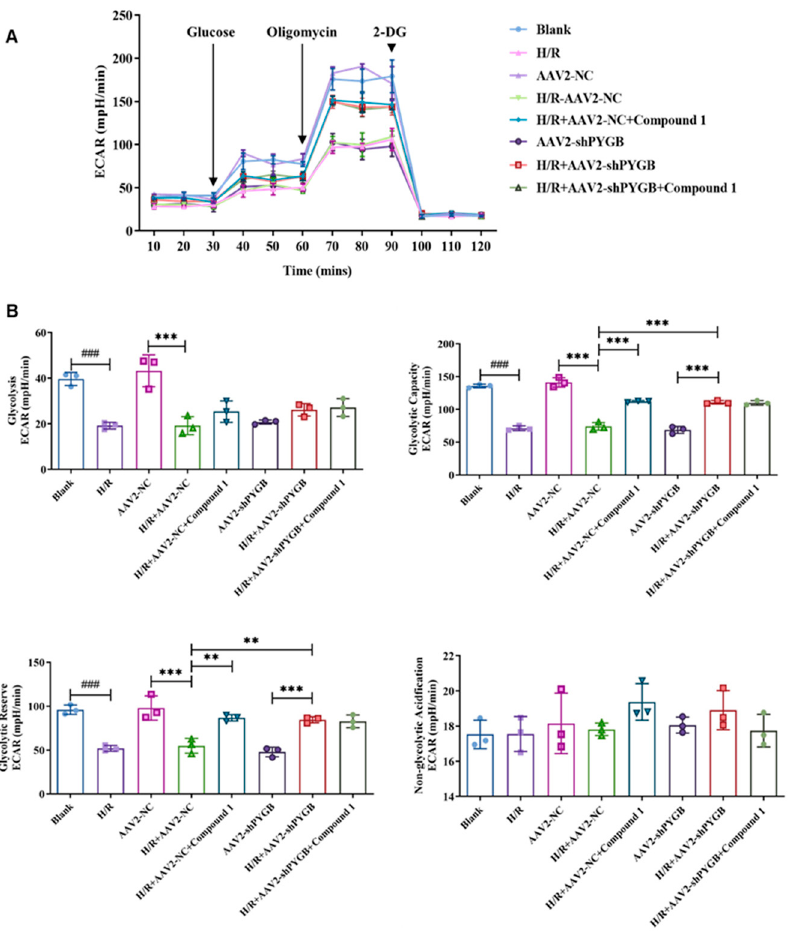
Figure 5. ( A ) Mouse astrocytes after H/R treatment with various drug administration methods; ECAR was detected using the Seahorse XF Extracellular Flux Analyzer. Three drugs were added sequentially: glucose, oligomycin, and 2-DG. ( B ) Bar graphs of glycolysis, glycolytic capacity, glycolytic reserve, non-glycolytic acidification. Data represent mean ± SD (** p < 0.01 *** p < 0.001; ### p < 0.001).